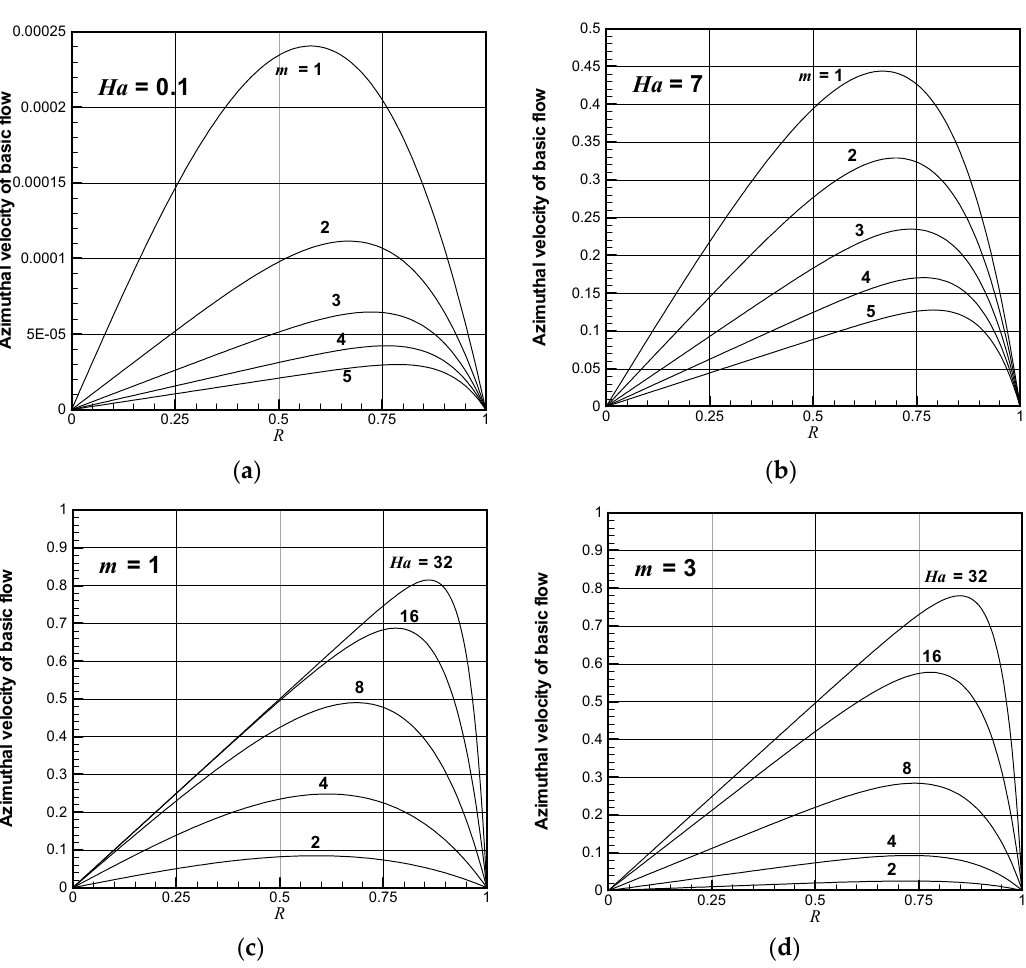
Figure 3. The azimuthal velocity of the basic flow for several numbers of the pole pairs and the Hartmann numbers. ( a ) Ha = 0.1; ( b ) Ha = 7; ( c ) m = 1; ( d ) m = 3.